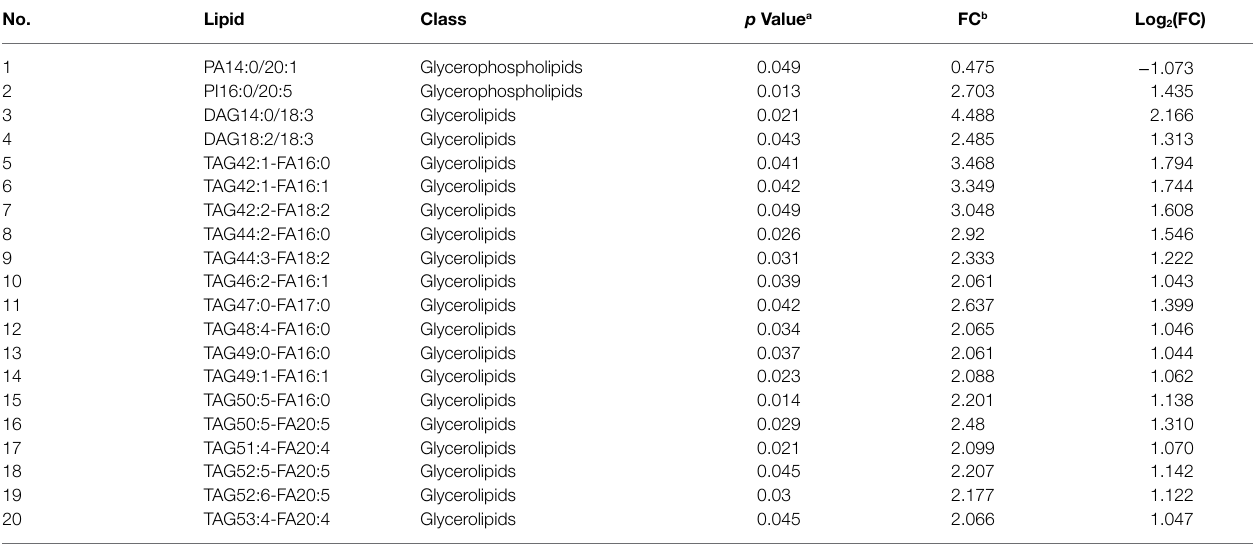
TABLE 3 | Lipids with different levels by EBV EA-IgA titers among NPC patients. No. Lipid Class p Value